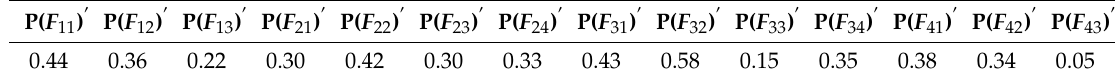
Table 8. The probability of the occurrence of coupled factors.